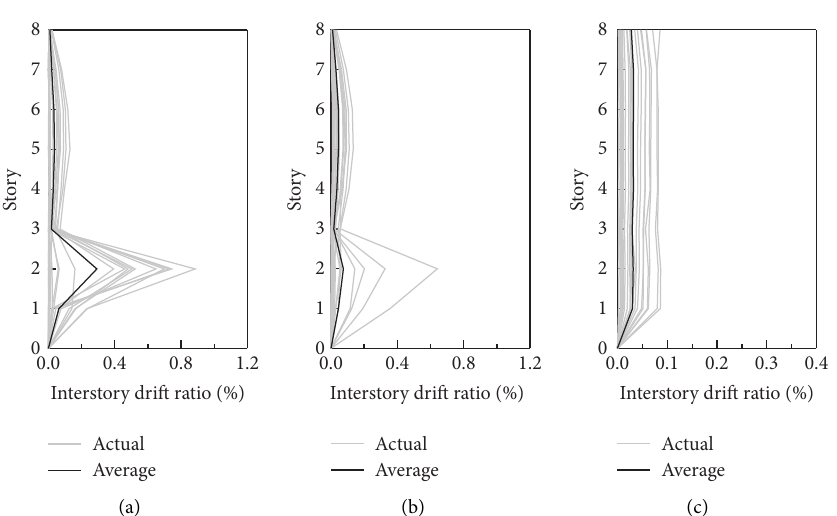
Figure 16: Comparison of the residual interstorey drifts under major earthquakes. (a) PRCFCP. (b) PRCFCP -USD. (c) PRCFCP -USD-